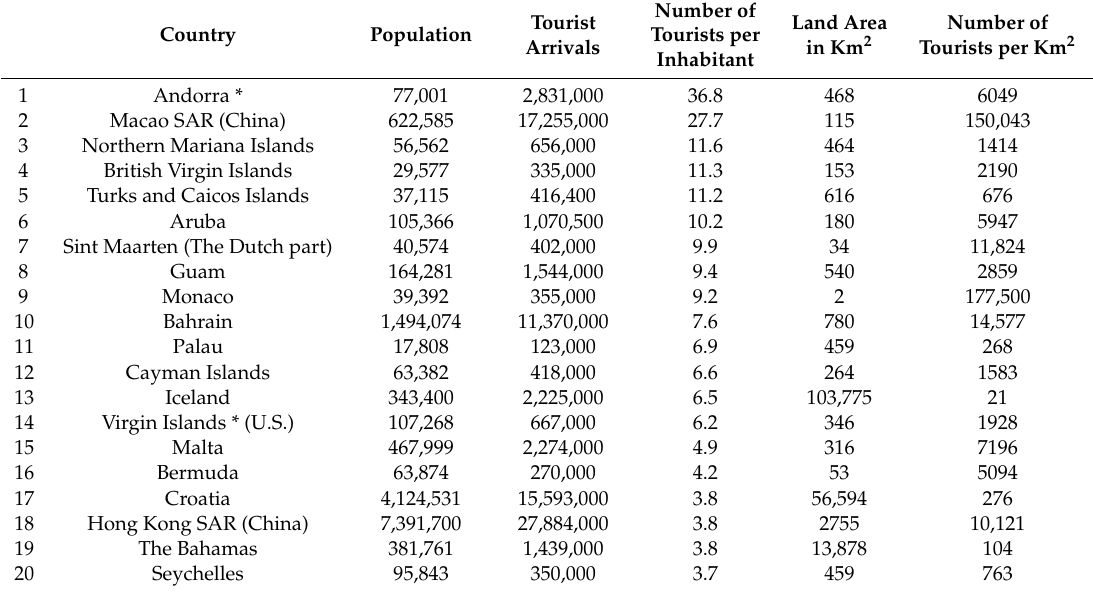
Table 1. The top 20 countries / special administrative regions with the highest ratio of number of tourists per inhabitant in